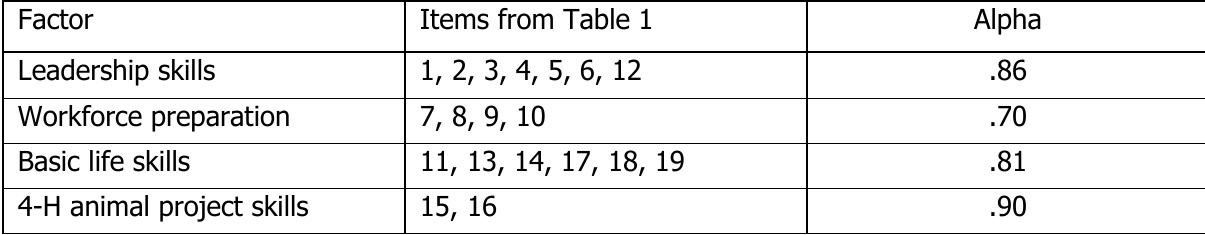
Scale structure and Cronbach alpha reliability coefficient for